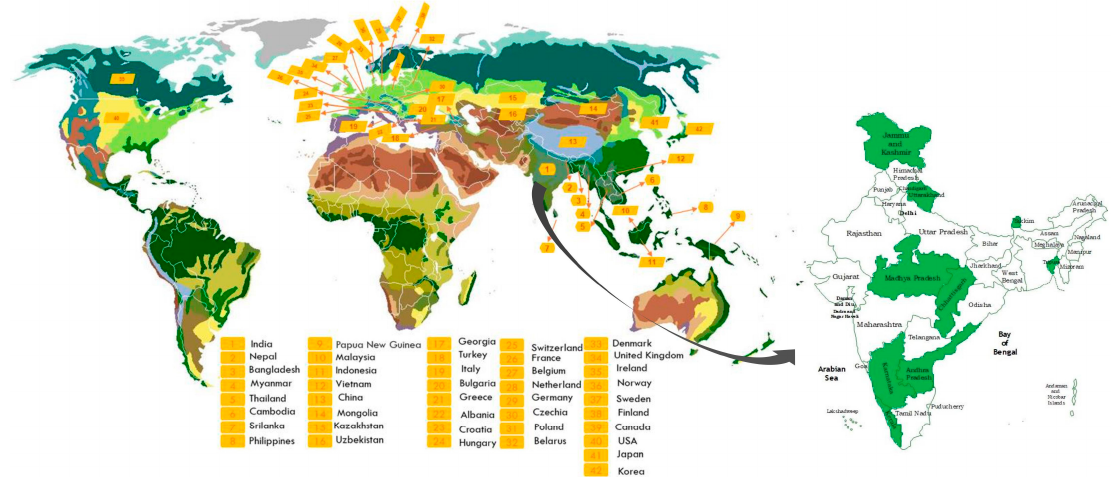
Figure 4. Distribution of A. calamus worldwide and in India.